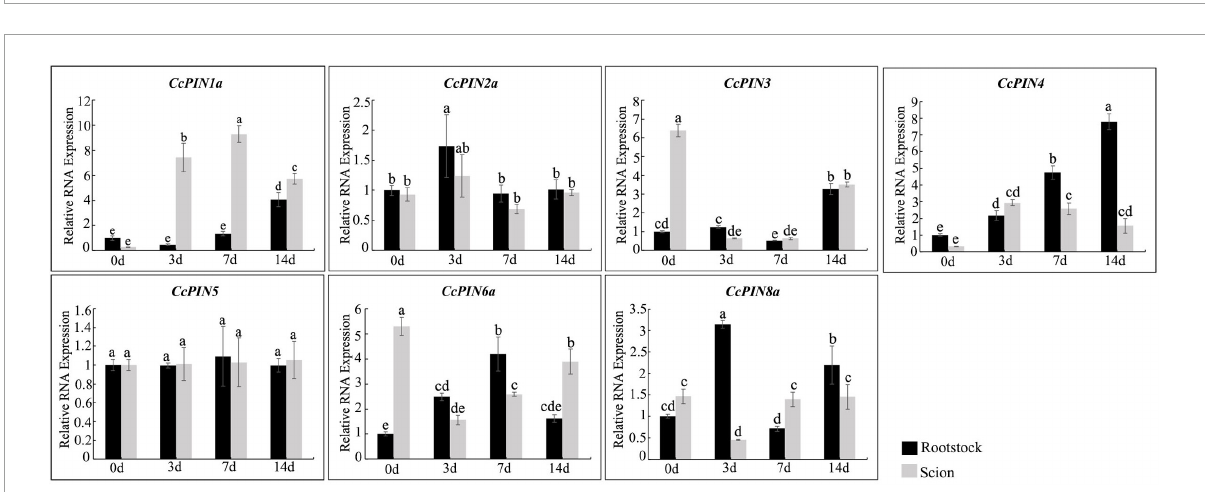
FIGURE8 Relative RNA expression of CcPIN genes during the grafting of Chinese hickory. 0, 3, 7, and 14 d denote 0, 3, 7, and 14 days after grafting, respectively. The rootstocks collected at 0 day were regarded as the control sample. Different letters above the columns denote a significant difference in different treatments ( P <